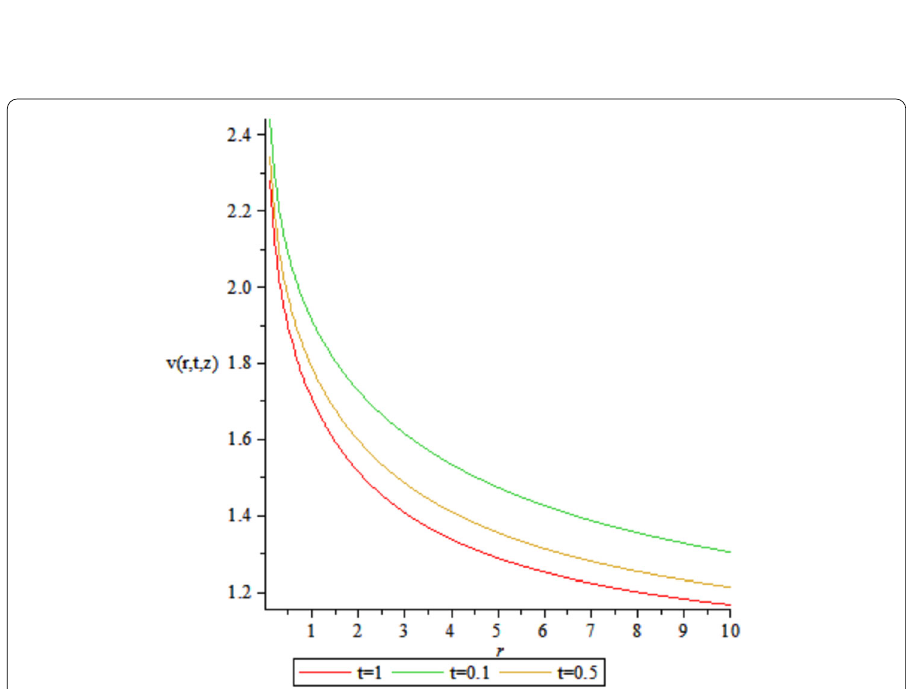
Figure 2 Positive case of velocity component v ( r , t , z ) at z = 2 and c 4 =